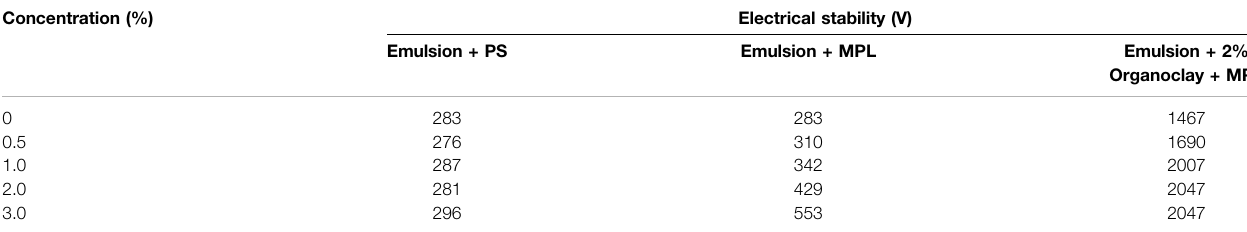
TABLE 1 | The in fl uence of polystyrene nanospheres and MPL on demulsi fi cation voltage. Concentration